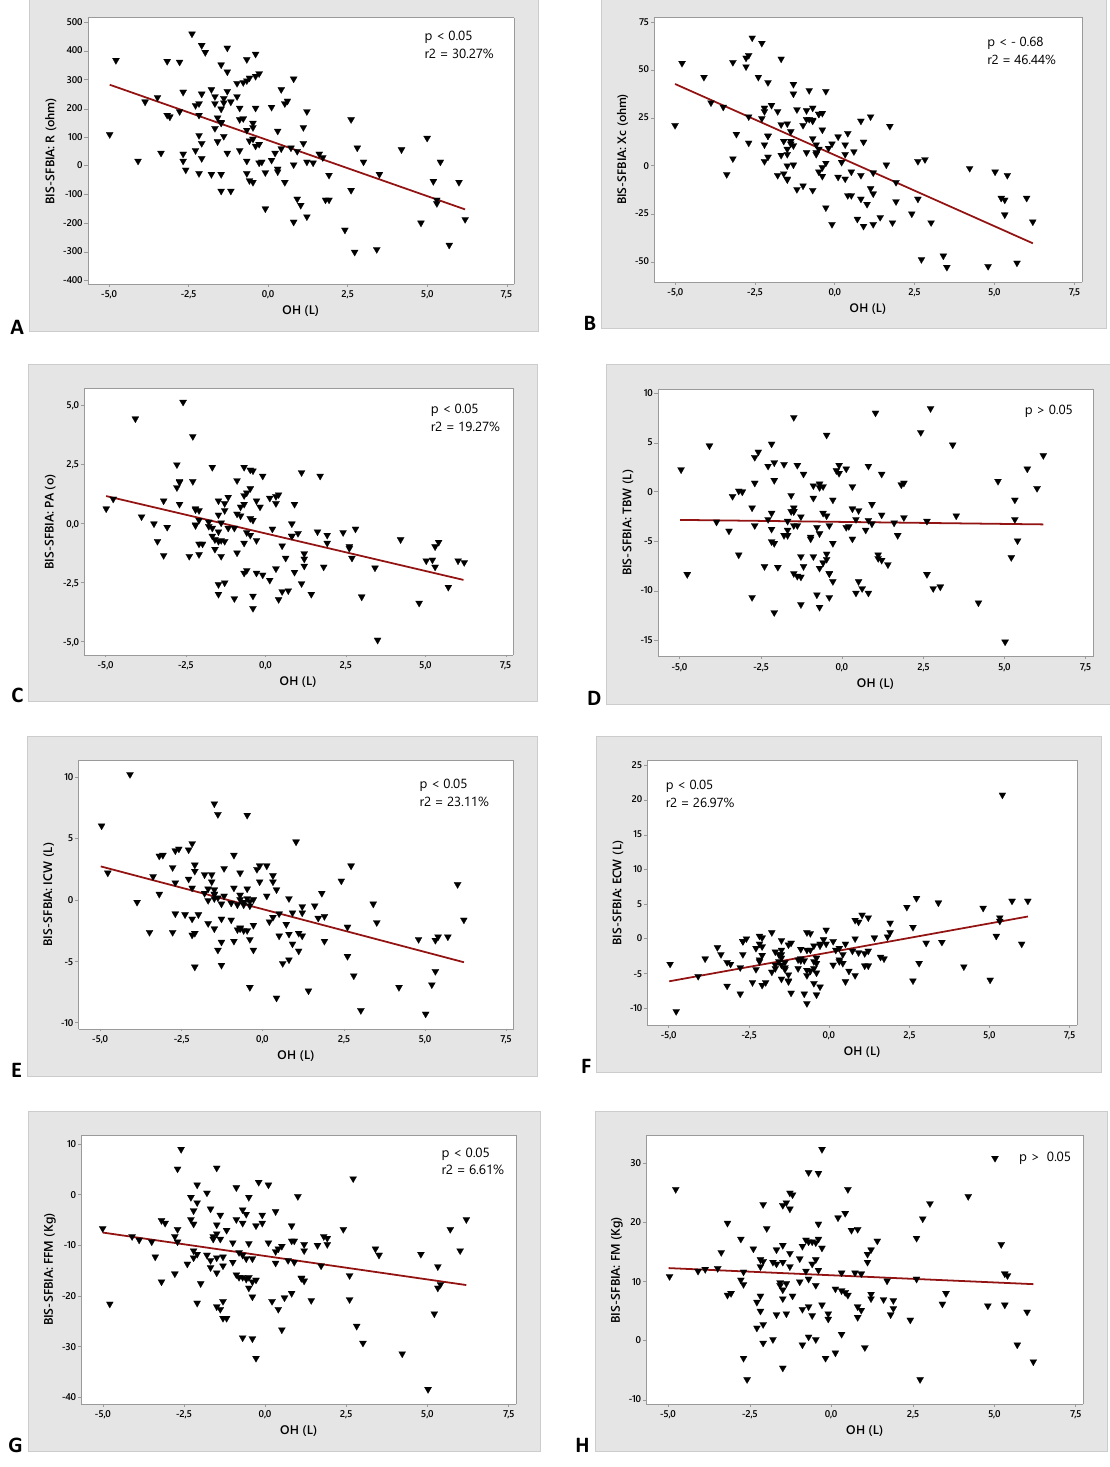
Figure 2: Regression analyze between BIS and SFBIA bias (BIS-SFBIA) with OH. Data analyzed only for CKD groups. BIS, multifrequency bioelectrical impedance spectroscopy; BMI, body mass index; CKD, chronic kidney disease; ECW, extracellular water; FFM, fat free mass; FM, fat mass; ICW, intracellular water; PA, phase angle; R, resistance; SFBIA, single-frequency bioelectrical impedance; TBW, total body water; OH, overhydration state; Xc, reactance. (a) R; (b) Xc; (c) PA; (d) TBW; (e) ICW; (f) ECW; (g) FFM; (h)